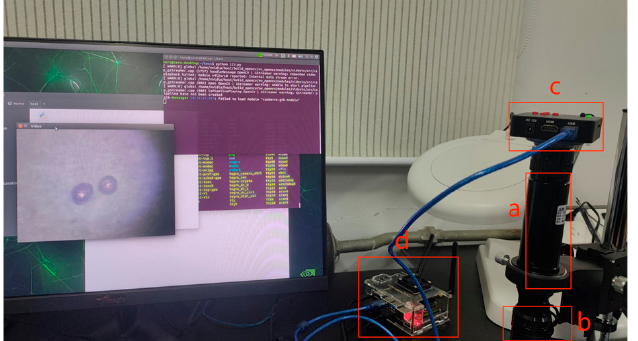
Figure 2. Entire platform: ( a ) Small coaxial optical industrial microscope; ( b ) Objective lens; ( c ) CCD image sensor; ( d ) Jetson Nano device.